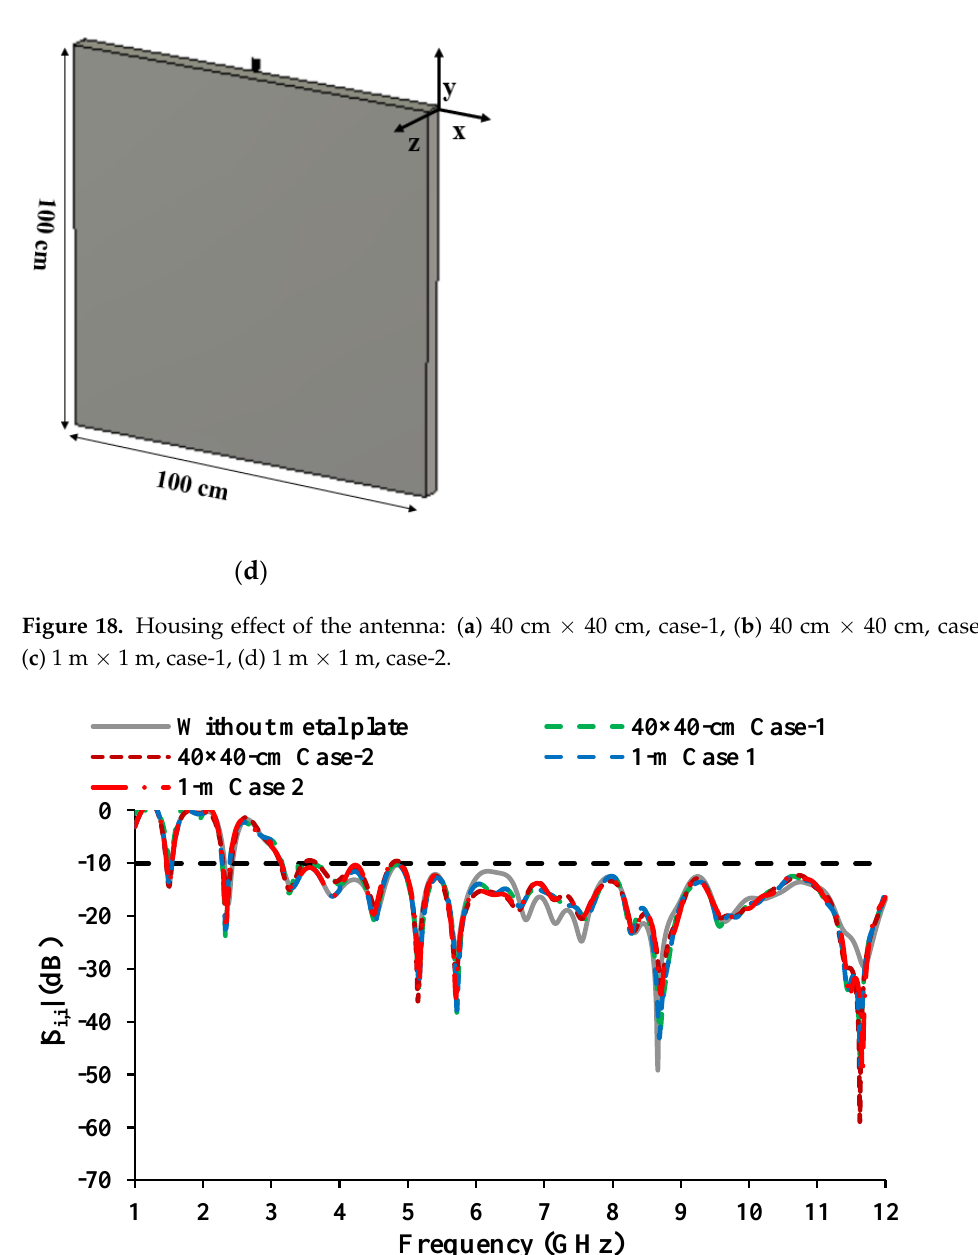
Figure 19. S-parameters of the antenna considering the housing effect.